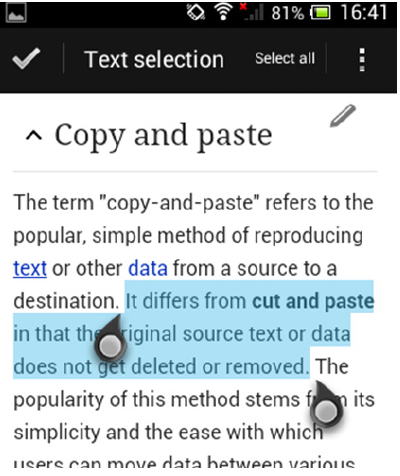
Fig. 1. Conventional copy and paste interface used in touch screen